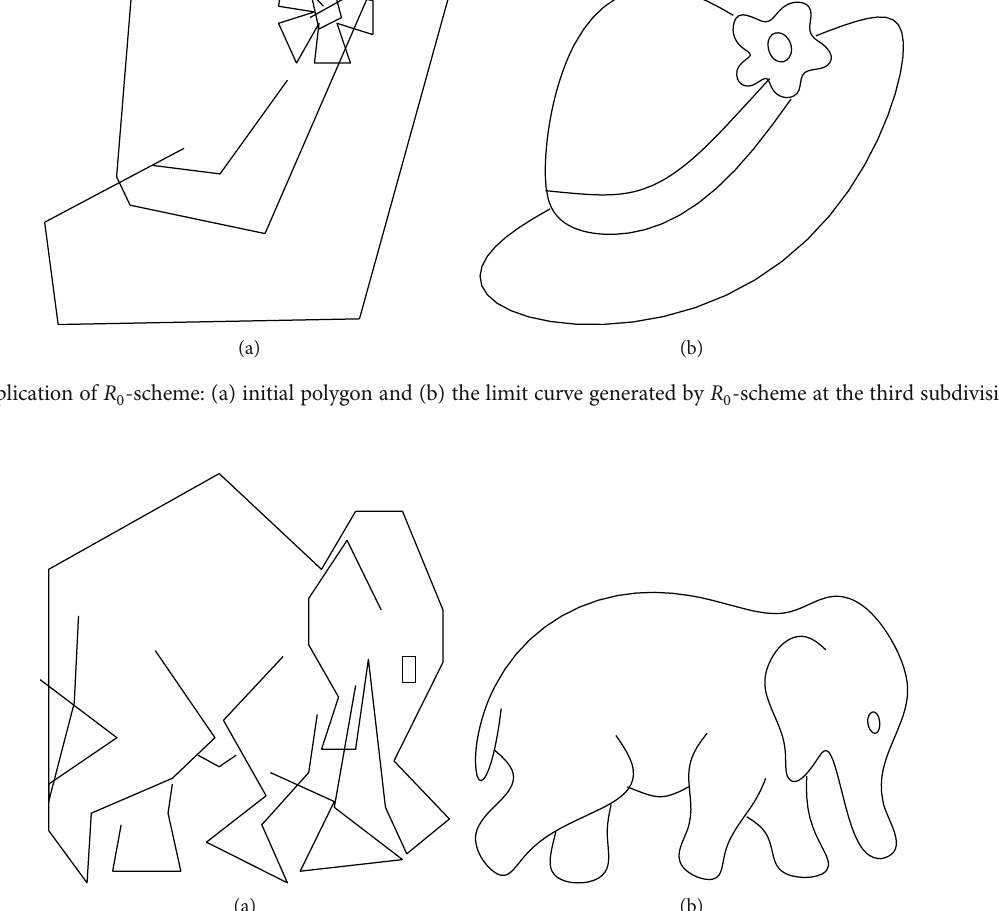
- scheme: (a) initial polygon and (b) the limit curve generated by R 0